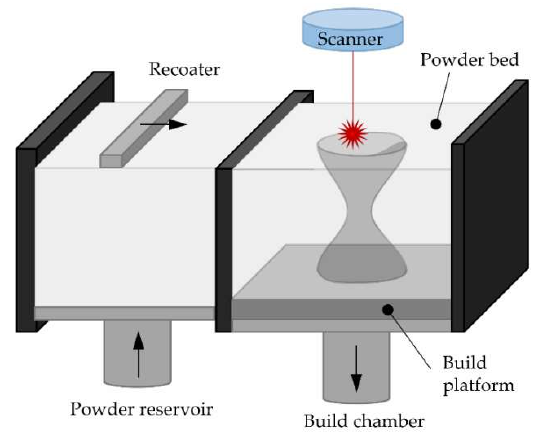
Figure 3. Basis of the Powder Bed Fusion (PBF) processes.